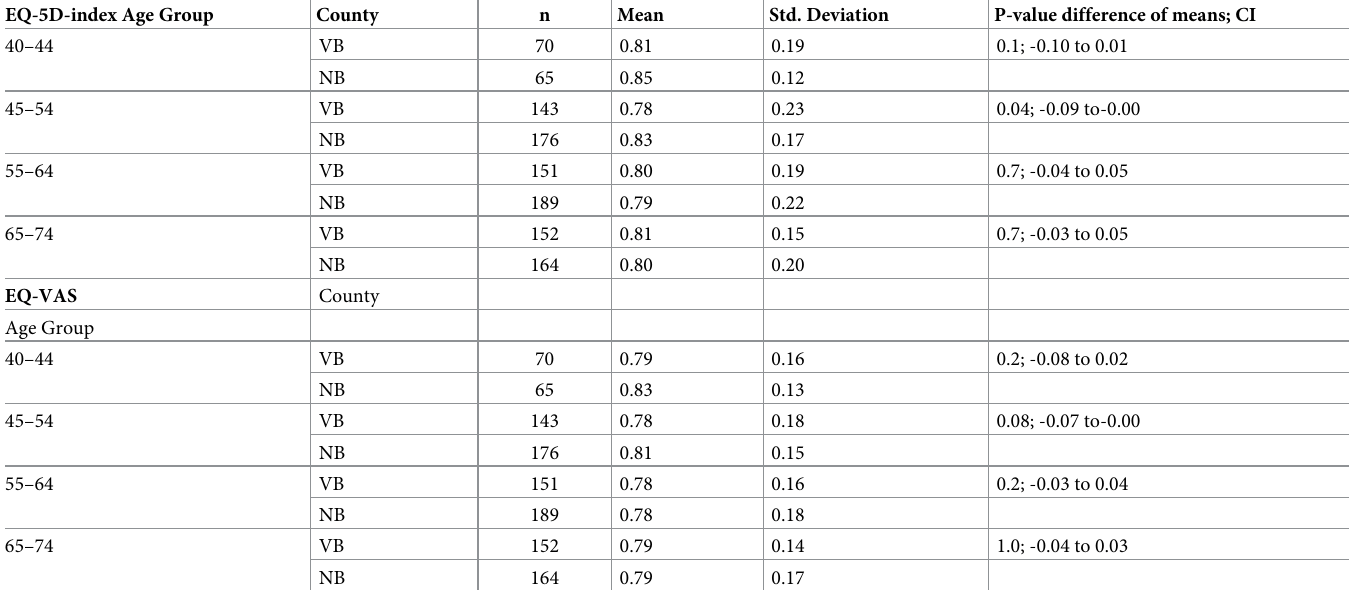
Table 4. EQ-5D-index and EQ-VAS, by age group and county. EQ-5D-index Age Group